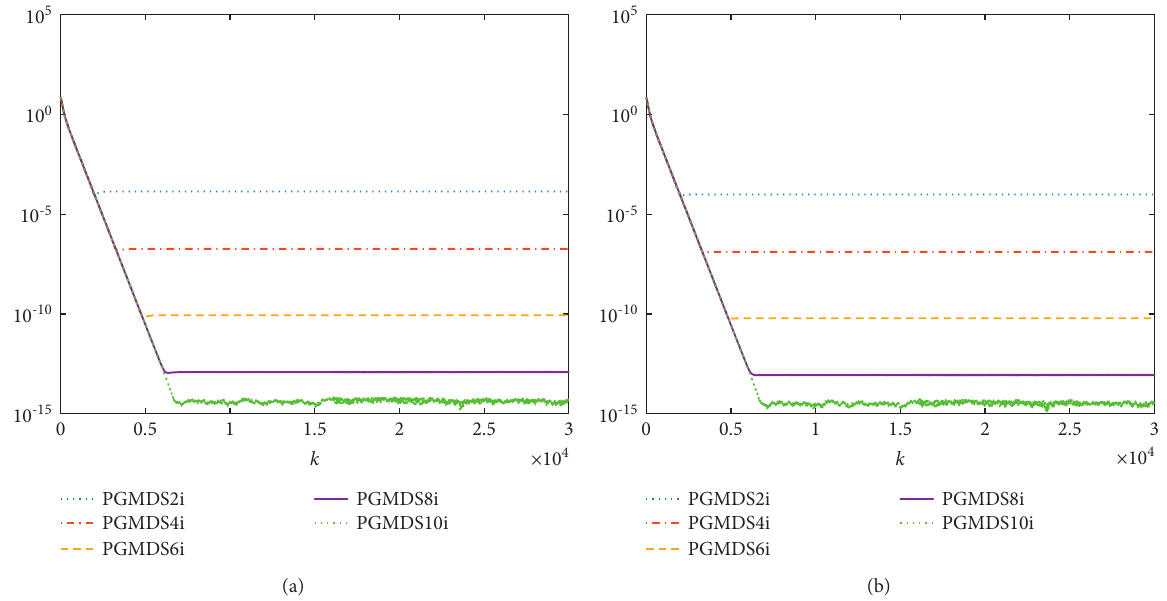
Figure 3: Residual error trajectories synthesized by five PGMDS algorithms for example 1 (with ϵ � 0 . 001 s and c � 5 . 0). (a) Trajectories of A − I ‖ ‖ X . (b) Trajectories of ‖ X k + k + 1 k + 1 F